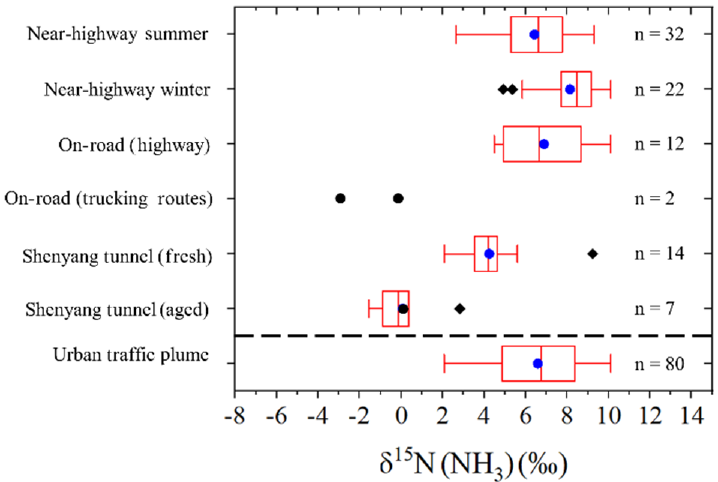
Figure 7. Box and whisker plot summarizing the distribution (lower extreme, lower quartile, median (blue circle), upper quartile, upper extreme, and outliers (black diamond)) of δ 15 N ( NH 3 ) measurements from near-highway, on-road, and tunnel sampling. The “Urban traffic plume” category represents the combination of δ 15 N ( NH 3 ) measurements from the near-highway, on-road (highway), and Shenyang tunnel (fresh) sampling. No statistical summary is provided for “On-road (trucking routes)”, due to the limited number of samples in this